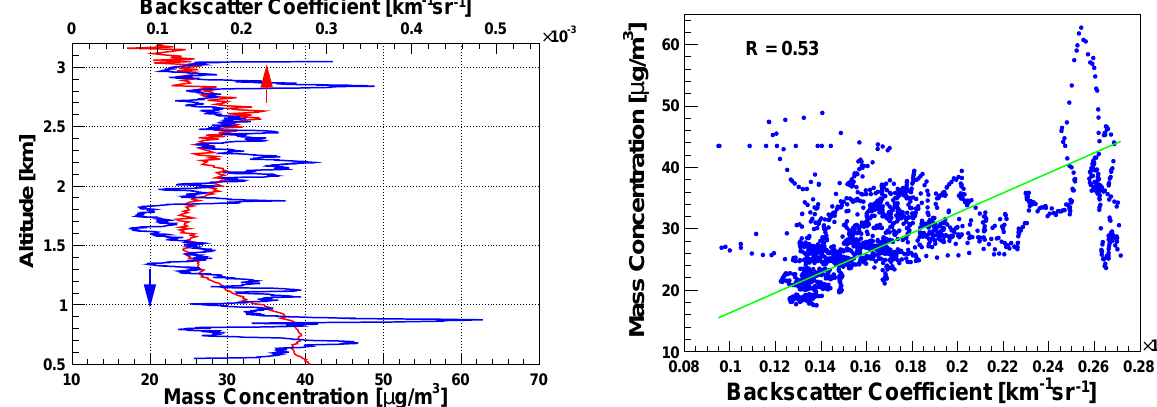
Fig. 15. Total particle matter (TPM) content from the airborne measurement and aerosol backscatter coefficient obtained by lidar were found to be correlated. The correlation can be seen qualitatively from the overlap of the TPM ( c ) profile over Divaˇca and aerosol backscatter coefficient ( β ) profile over Nova Gorica simultaneously measured at 15:20CET on 20 April 2010 (left). The correlation between c and β was found to be linear, c = ( 162914 ± 765 )β , with a correlation coefficient of 0.53 (right). In the fit, β was constrained to zero for the limit case when the TPM is zero.